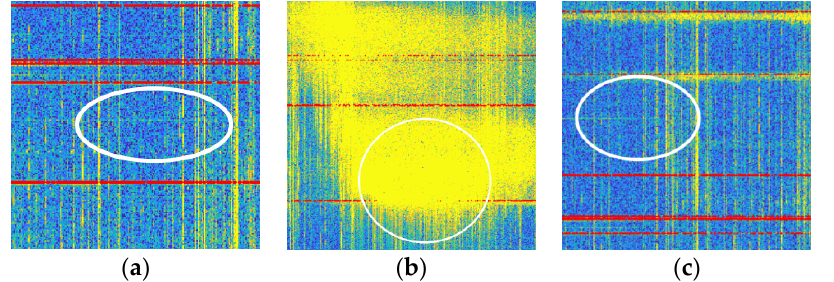
Figure 9. Marking and analysis of test results. ( a ) weak signal; ( b ) other electromagnetic wave in- terference; ( c ) signal interruption. interference; ( c ) signal